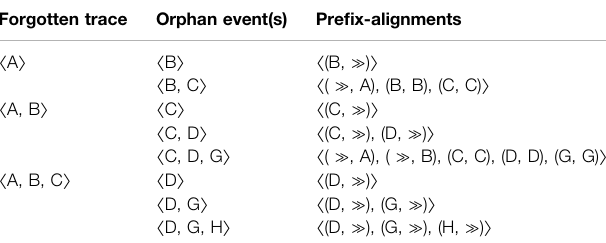
TABLE 2 | Example pre fi x-alignments for case “ 7 ” of event log of Table 1 with inactivity-based forgetting at different pre fi x lengths. Forgotten trace Orphan